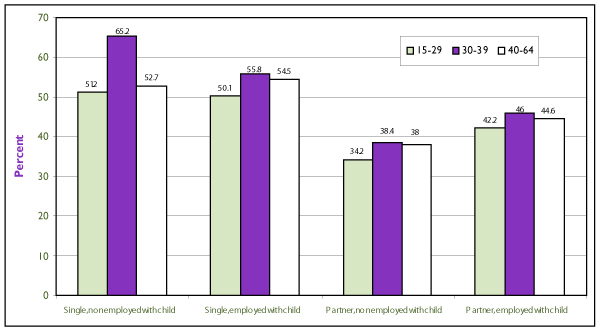
Proportion of Women With High Personal Stress by Multiple Roles and Age, Canada, NPHS, 1994–1995